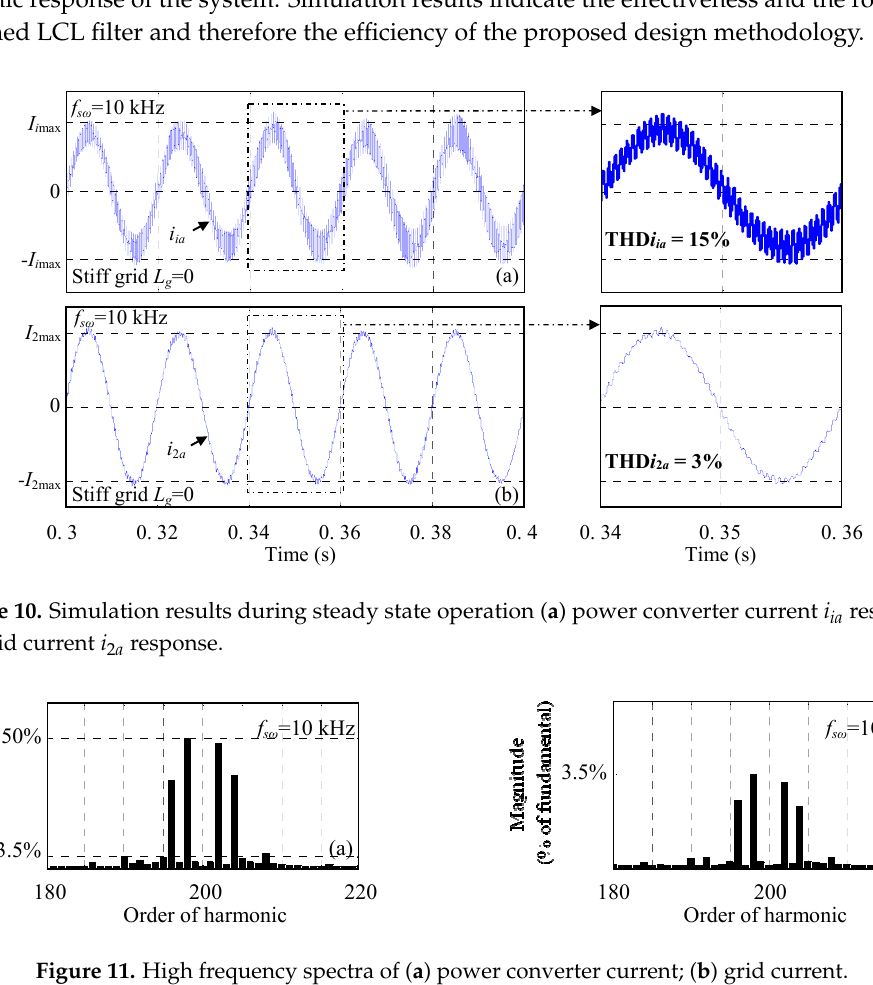
Figure 11. High frequency spectra of ( a ) power converter current; ( b ) grid current.